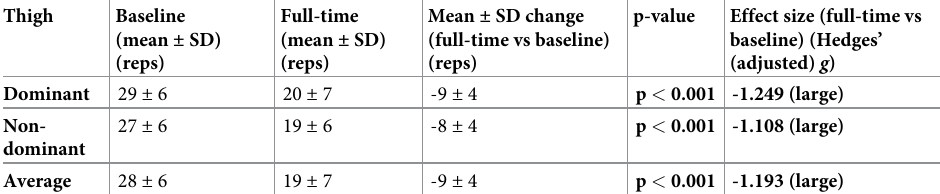
Table 3. Alterations in the SLHB performance (n =